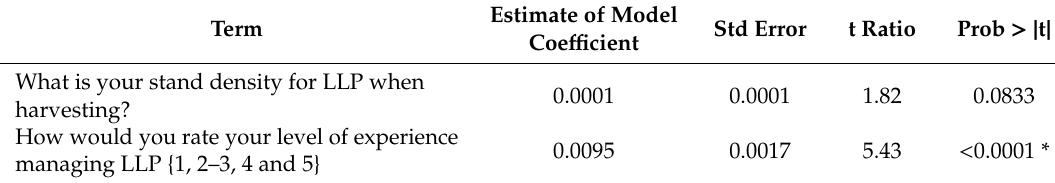
Table 2. Parameter estimates—distance from protected land.